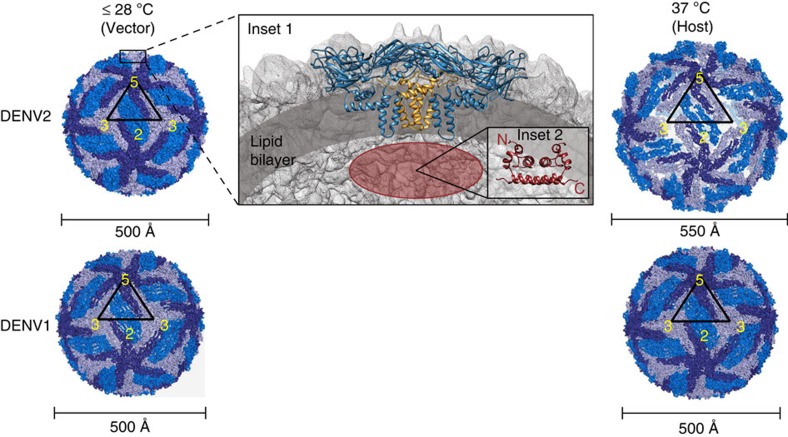
Temperature-dependent changes in DENV1 and 2 accompanying transmission from mosquito vector (28 °C) to human host (37 °C).Cryo-EM structures of DENV1 and DENV2 icosahedral particles (Triangulation, T=3) showing symmetry units of E-proteins straddling the five-fold (pentamer), two-fold (dimer) and three-fold (trimer) vertices in dark, medium and light blue respectively. The triangle highlights a single symmetry unit and the numbers indicate the five-fold, three-fold vertices and two-fold midpoint. Left, cryo-EM structure of smooth, compact DENV2 (PDB ID: 3J27, 3.5 Å resolution) and DENV1 (PDB ID: 4CCT, 4.5 Å resolution) at 28 °C (environment inside the mosquito vector). Right, cryo-EM structure of expanded DENV2 (PDB ID: 3ZKO, 13 Å resolution) and unexpanded DENV1 (PDB ID: 4CCT, 4.5 Å resolution) at 37 °C (environment within human host following transmission). White spaces at three-fold icosahedral vertices indicate exposed regions of the lipid bilayer upon expansion. Inset 1: DENV structural proteome. Cryo-EM structures of DENV E (blue) (PDB ID: 3J27) and M (yellow) (PDB ID: 3J27) proteins shown in the context of the viral structure. The lipid bilayer is highlighted in dark grey. Since C-proteins are not observable in the cryo-EM structures of intact DENVs, an approximate position (region coloured red) based on its proposed role in bridging the RNA genome (not shown) beneath the lipid bilayer is represented. Inset 2: NMR structure of C (red) (PDB ID: 1R6R) protein dimer. The N and C-termini of one C-monomer are labelled.